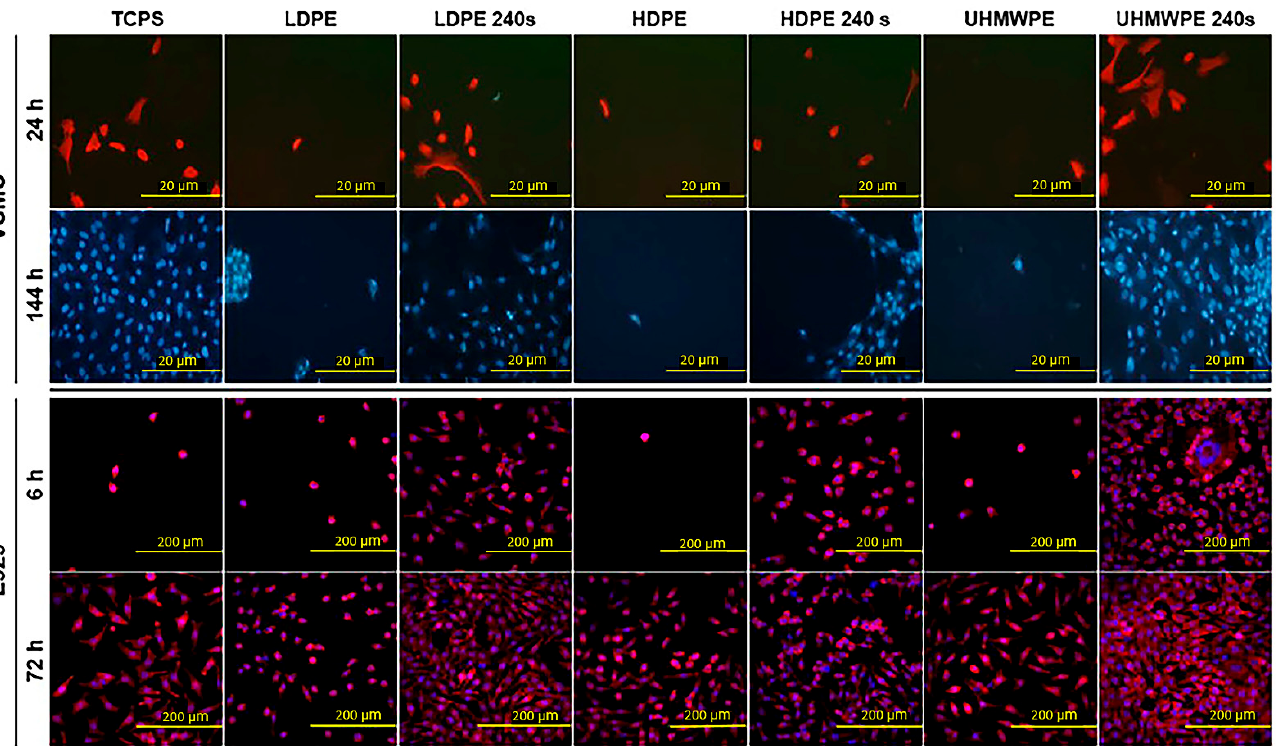
Figure 7. VSMCs and L929 cells adhered (6 or 24 h) and proliferated (72 or 144 h) on pristine and plasma-treated PE (LDPE, HDPE, UHMWPE) (Reproduced from Reznickova et al., Mater. Sci. Eng. C 2015, 52, 259–26 [270], with permission from Elsevier, 2015.